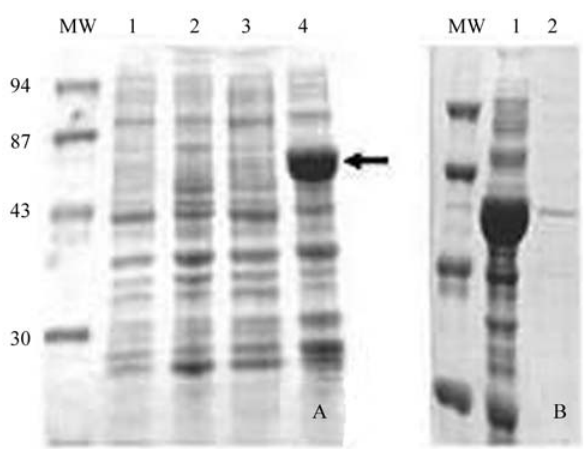
Figure 3 - Over-expression of the BglH protein in Escherichia coli BL21 CodonPlus(DE3) was analyzed by 12% SDS-PAGE. Proteins were stained with Coomassie Blue R-250. a) Lane 1, lysate from untransformed cells not induced with IPTG; Lane 2, lysate from untransformed cells in- duced with IPTG; Lane 3, lysate from transformed cells with pAB1 not in- duced with IPTG; Lane 4, lysate from transformed cells with pAB1 induced with IPTG. b) Lane 1, lysate from transformed cells with pAB1 induced with IPTG; Lane 2, Purified protein obtained from transformed cells with pAB1. Molecular weight markers (MW) are indicated in kDa. Arrow indicates the BglH